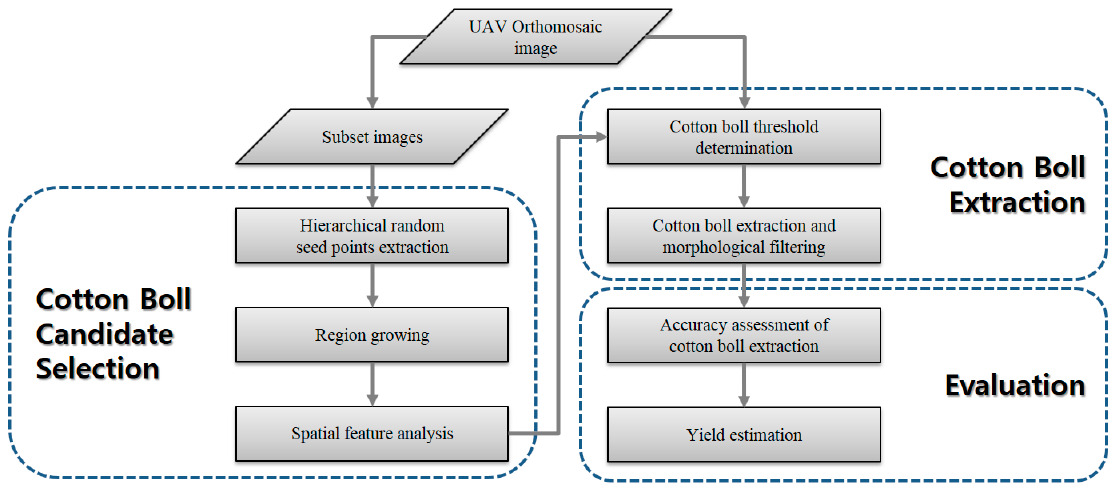
Figure 1. Overall methodology workflow. UAV: unmanned aerial vehicle.